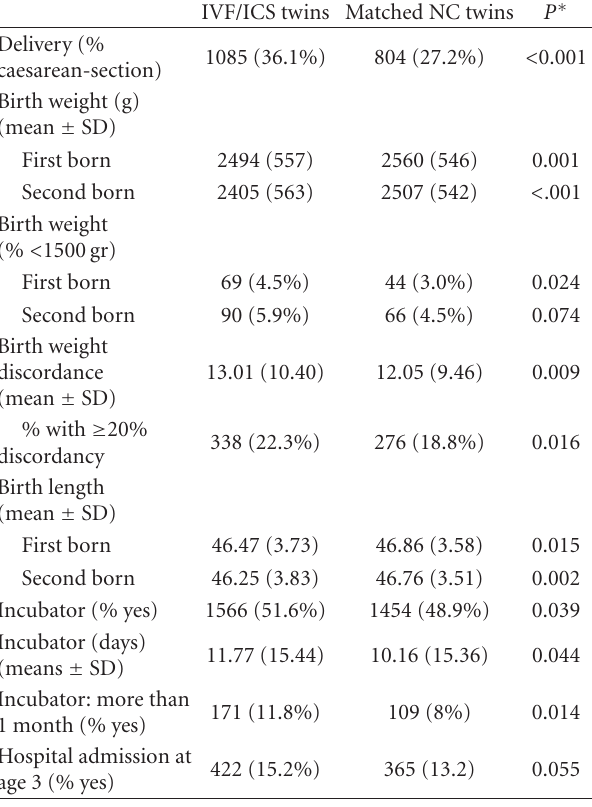
Table 2: Mode of delivery, birth weight and length, incubator, and hospital admission for IVF/ICSI twins and matched NC twins.